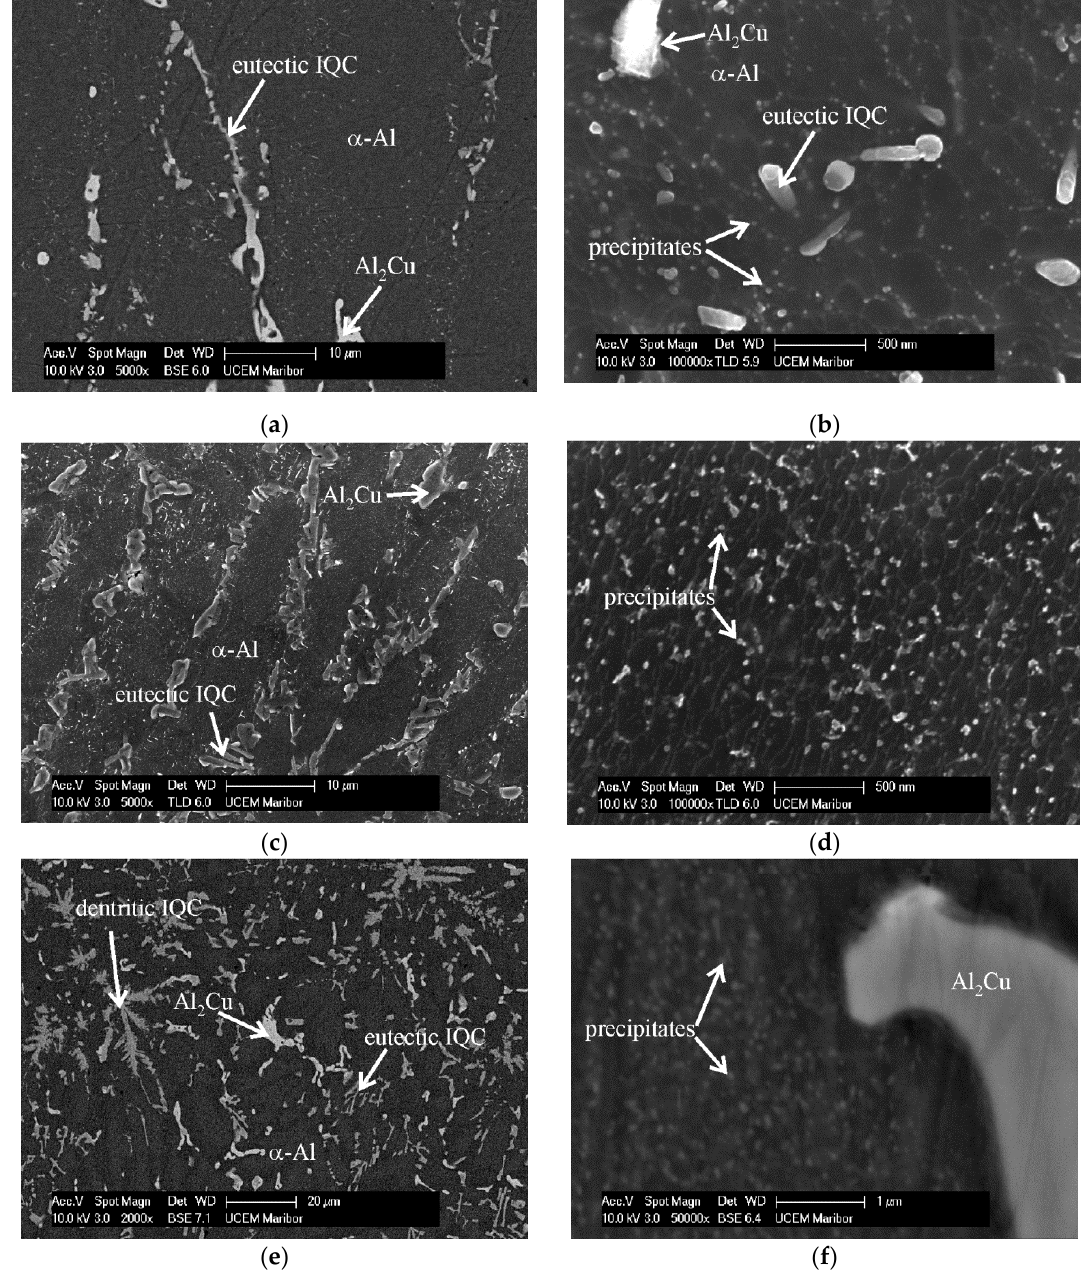
Figure 4. Backscattered electron micrographs of the alloys. ( a , b ) Al 96.5 Mn 0.8 Cu 1.2 Be 1.5 and ( c , d ) Al 95.4 Mn 1.8 Cu 1.6 Be 1.2 aged at 300 ◦ C for 168 h, and ( e , f ) the alloy Al 95.4 Mn 1.8 Cu 1.6 Be 1.2 aged at 400 ◦ C for 1 h. The diameter of samples was 10 mm. The samples were etched using a methanol-iodine solution. For the TEM investigation, the 4 mm diameter samples of the alloy Al 95.4 Mn 1.8 Cu 1.6 Be 1.2 were